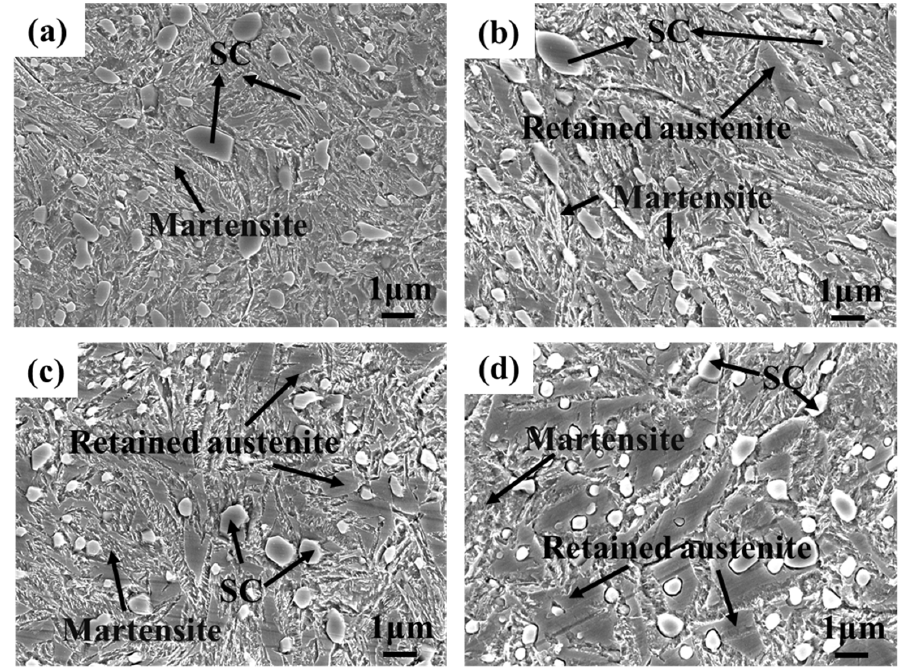
Figure 9. SEM images of the matrix of CICs after heat treatment: ( a ) CIC ‐ 1; ( b ) CIC ‐ 2; ( c ) CIC ‐ 3; ( d ) CIC ‐ 4.